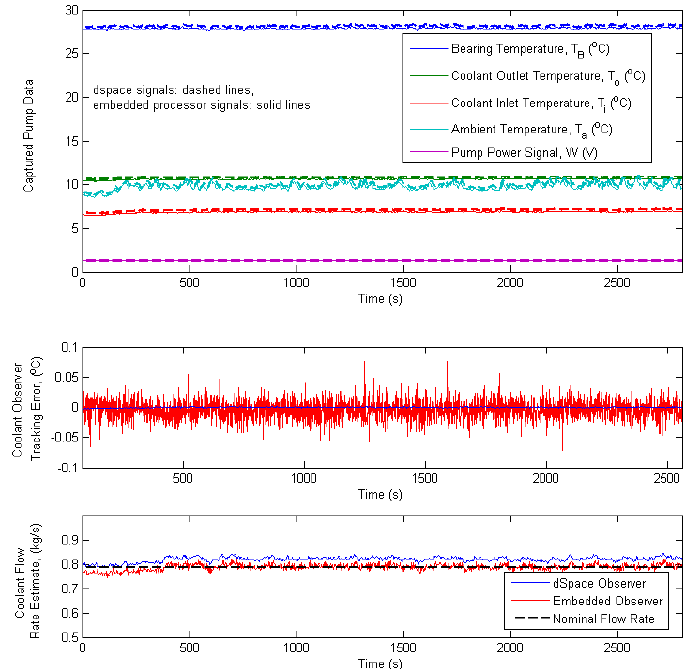
Figure 9. Comparative analysis of the Simulink-based and edge device-based observers (baseline case).